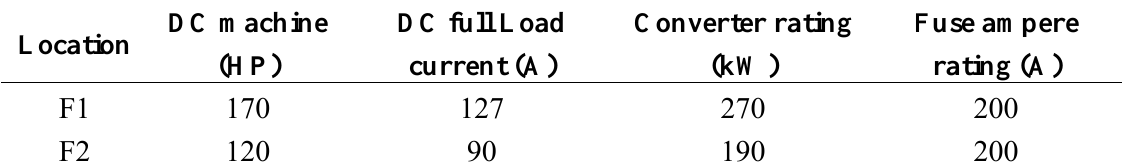
Table 1. Summary of the loading